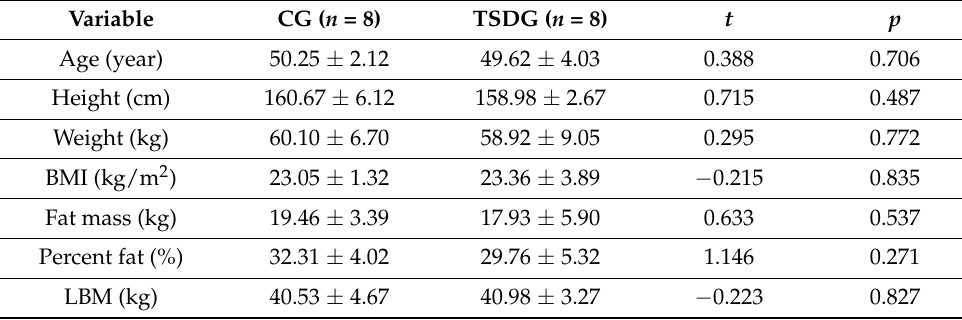
Figure 1. The experimental design. Table 1. Characteristics of subjects.